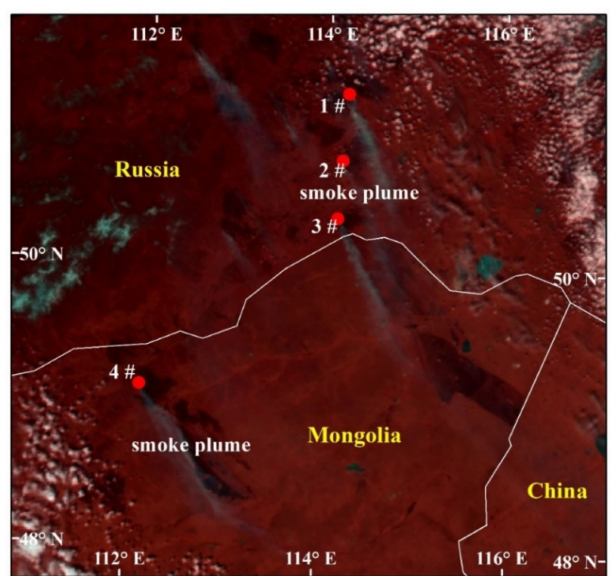
Figure 1. Moderate-resolution Imaging Spectroradiometer (MODIS) false-color image (red-green-blue (RGB) = 741) of study region. The white lines indicate national boundaries and the red point is fire point. Smoke plumes can be identified from the image. We found 3 active fires in Russia and 1 in Mongolia, but here, the study region is labeled